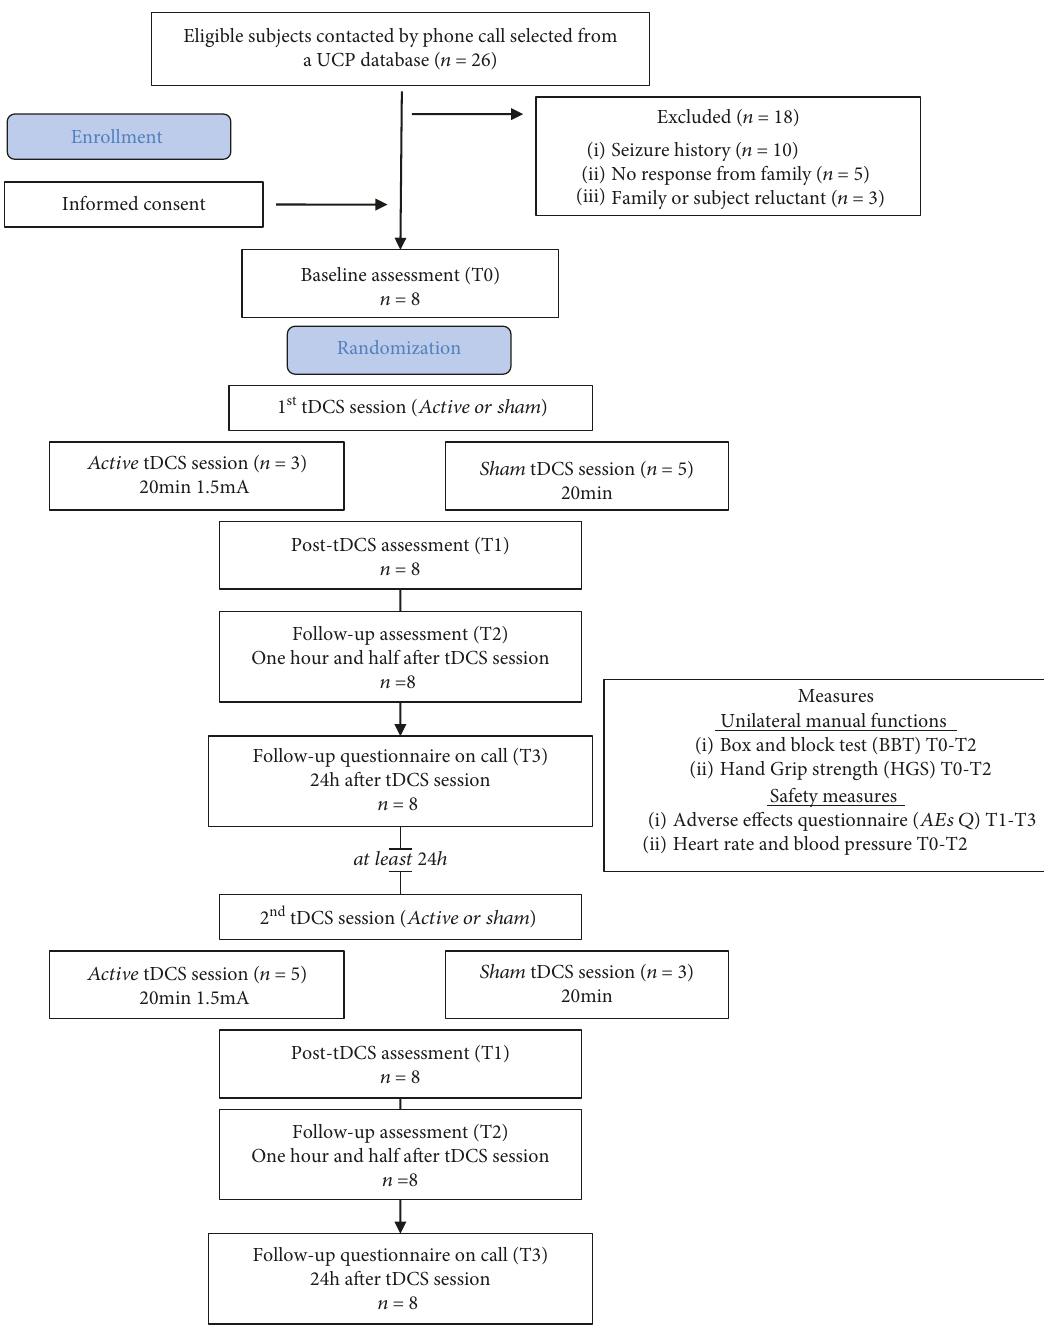
Figure 1: CONSORT diagram and study fl